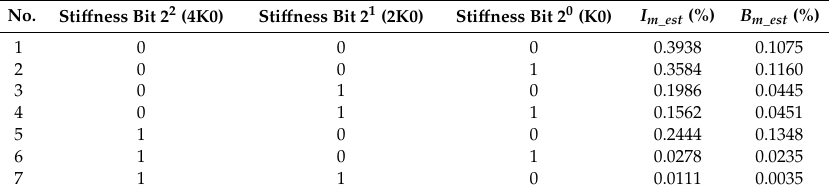
Table 2. Relative errors for the estimated parameters under the e ff ect of active and inactive clutches in the case of the first test.